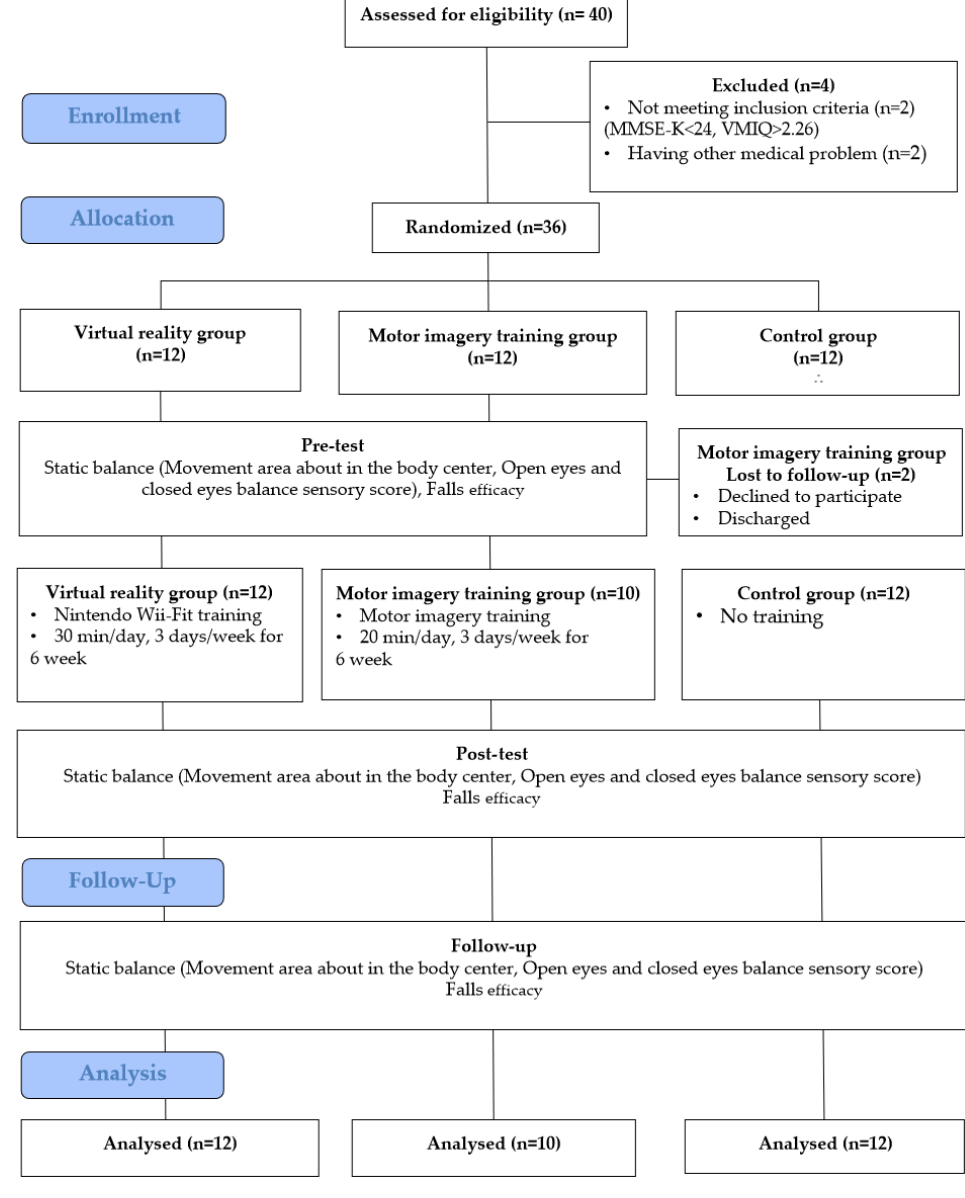
Figure 1. Research flow diagram.